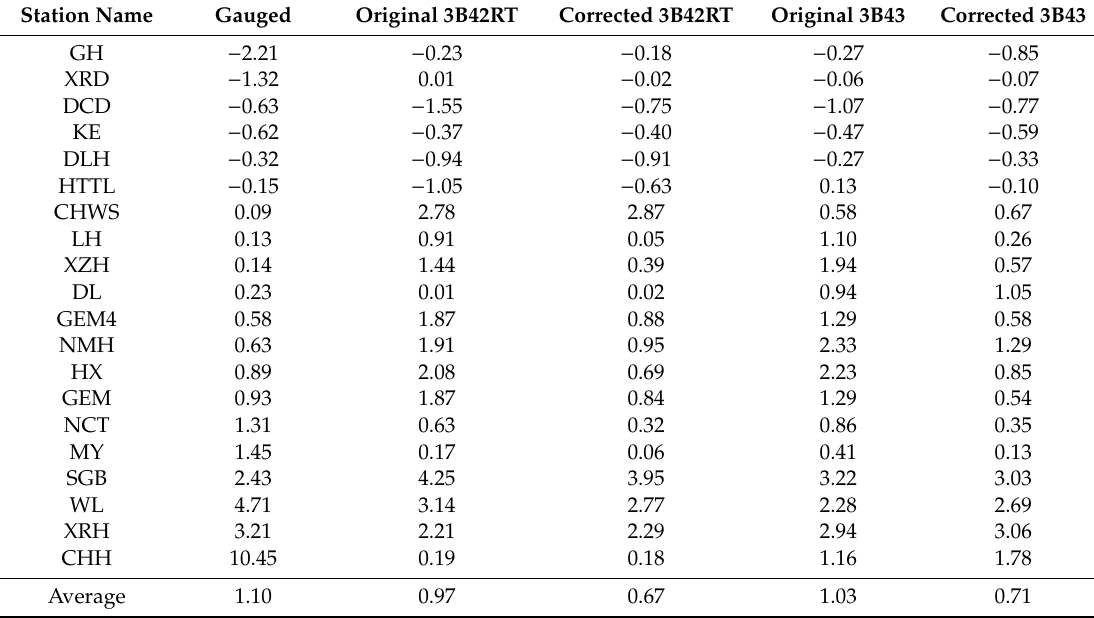
Table 4. Comparison of the annual precipitation variation trend (2001–2016) between gauged and Table4.